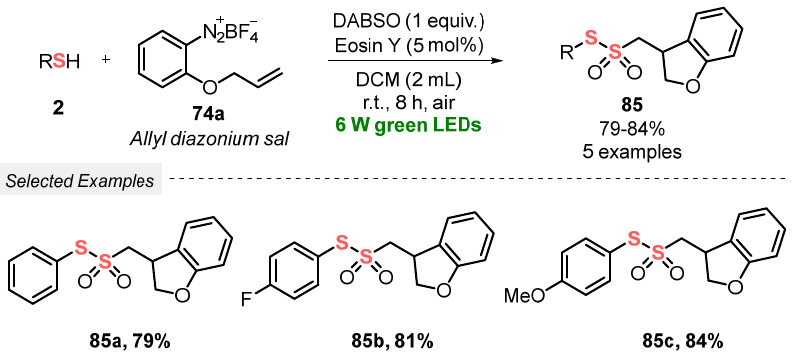
Scheme 46. Synthesis of nonsymmetrical thiosulfonates 22 promoted by green